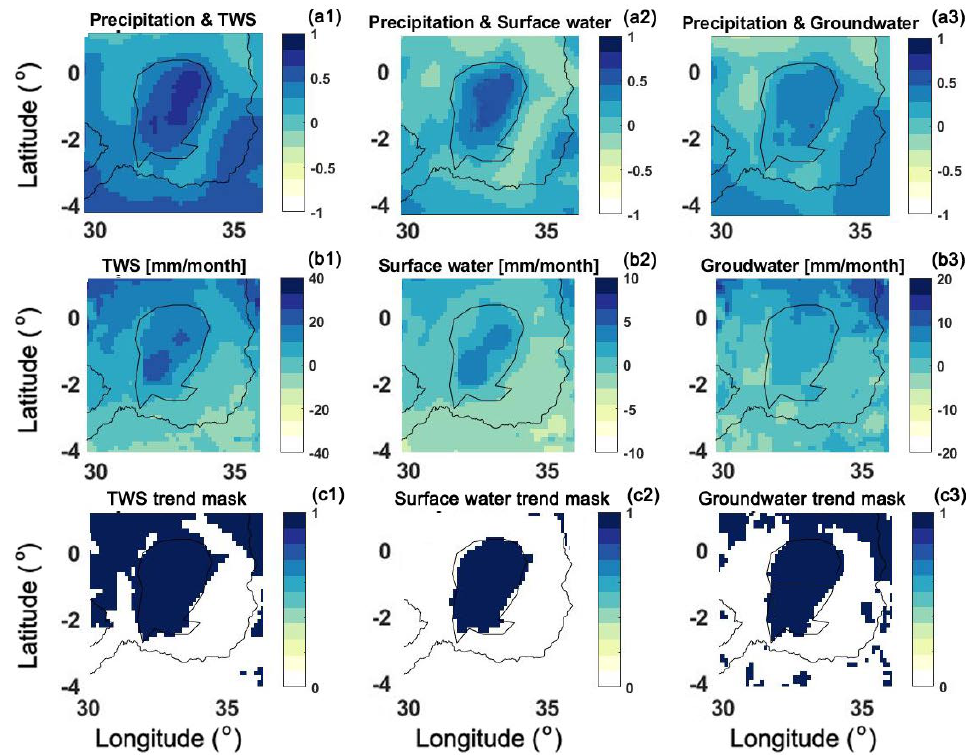
Figure 9. Correlation between precipitation and TWS ( a1 ), surface water ( a2 ), and groundwater ( a3 ) for the period of January 2019 to July 2020. TWS, surface water storage, and groundwater trends estimated from data assimilation results are presented in ( b1 ), ( b2 ), and ( b3 ), respectively. The corresponding trend mask are plotted in ( c1 ), ( c2 ), and ( c3 ), respectively, which show the grid points with significant trend